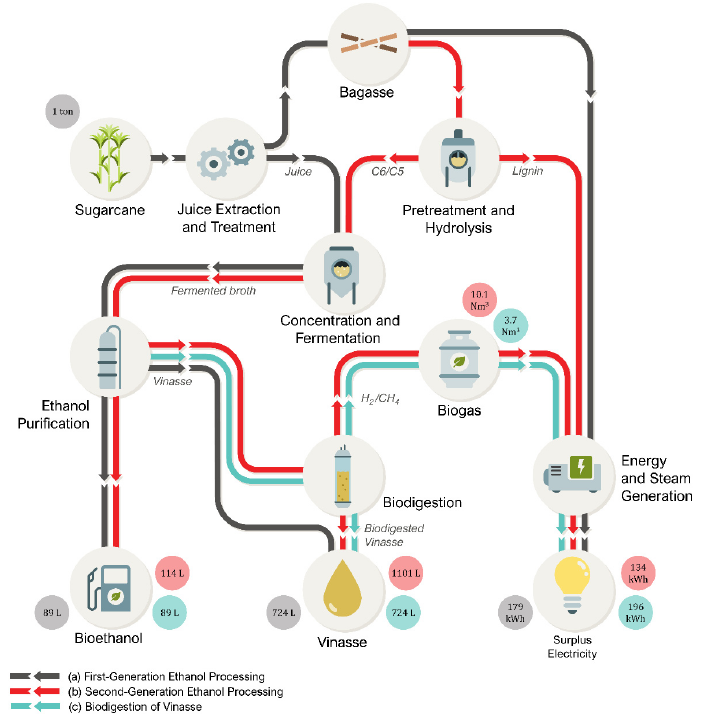
Figure 4. Conceptual processing of a sugarcane biorefinery, with expected yields for bioethanol, vinasse, surplus electricity, and biogas, in different configurations: (a) first-generation ethanol production without biodigestion of vinasse; (b) second-generation ethanol production with biodigestion of vinasse; and (c) biodigestion of vinasse a tt ached to traditional ethanol distillery— the main fl ow ( fi rst-generation) is not altered (adapted from Longati et al. [172]).